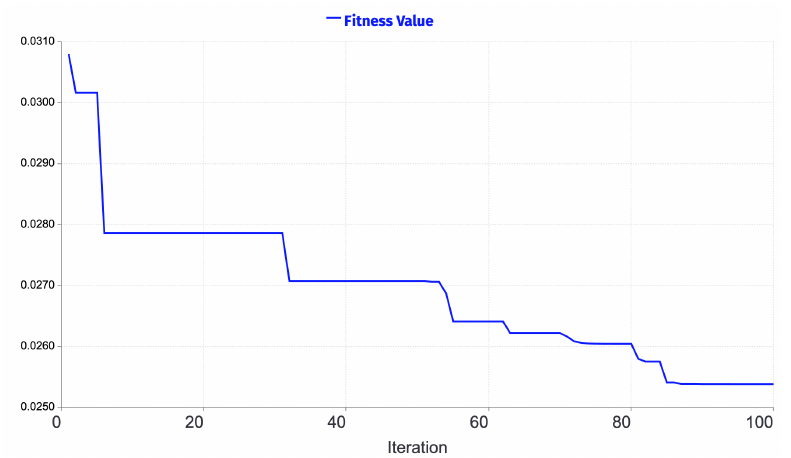
Figure A7. The training convergence curve when using the ANN with the PSO and the MSE fitness function for the dataset of Taiwanese companies.